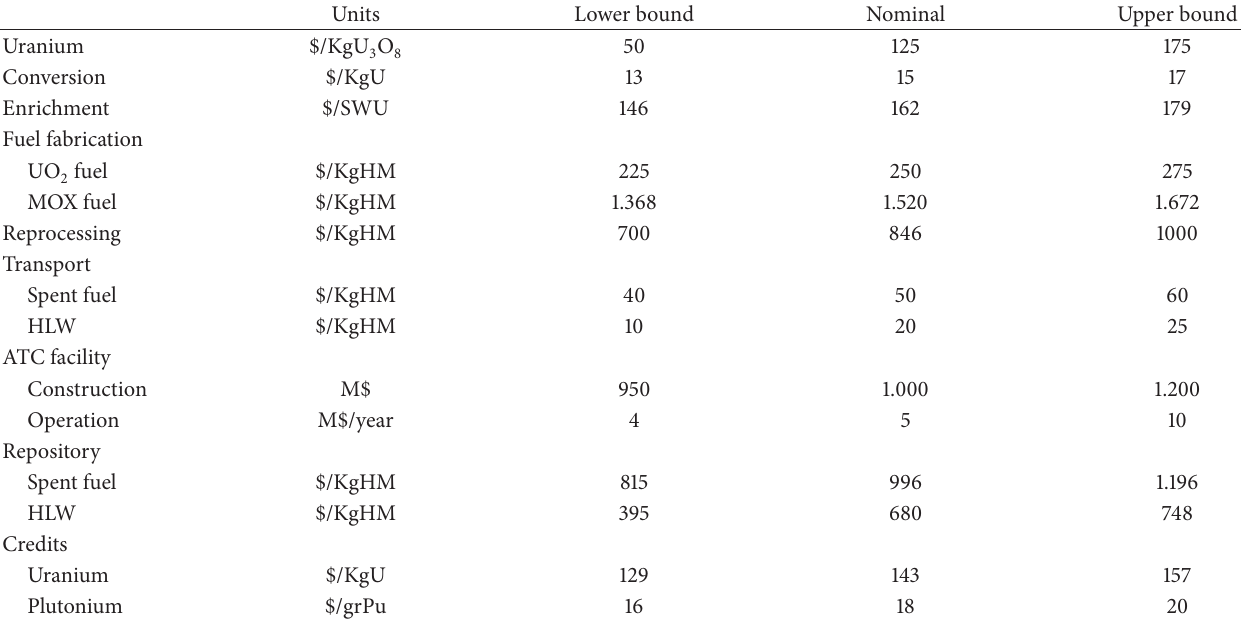
Table 1: Unitary